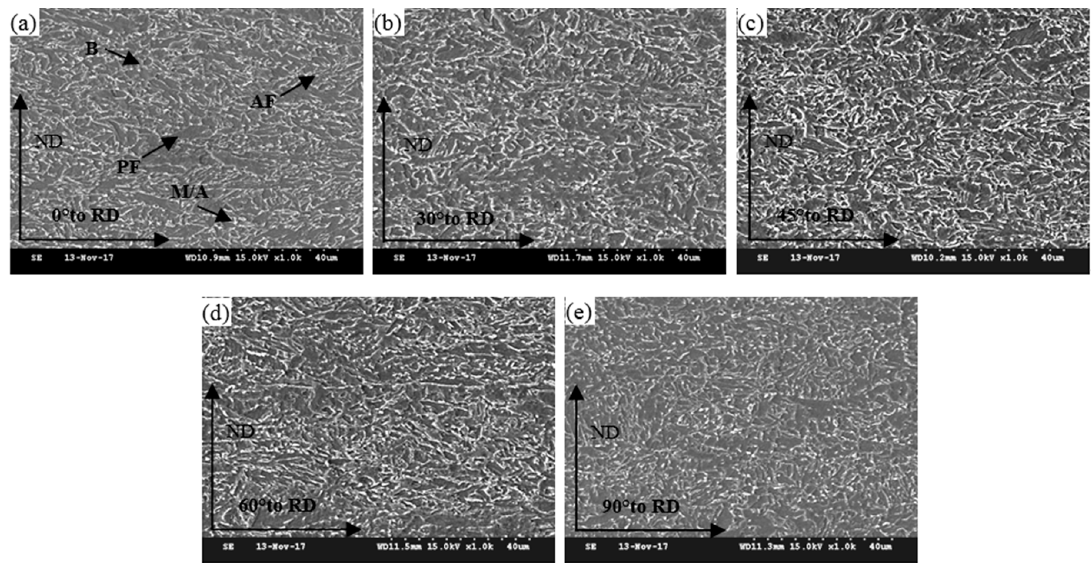
Figure 4. Scanning electron micrographs of samples in five directions: ( a ) 0° to RD, ( b ) 30° to RD, ( c ) 45° to RD, ( d ) 60° to RD, and ( e ) 90° to RD.